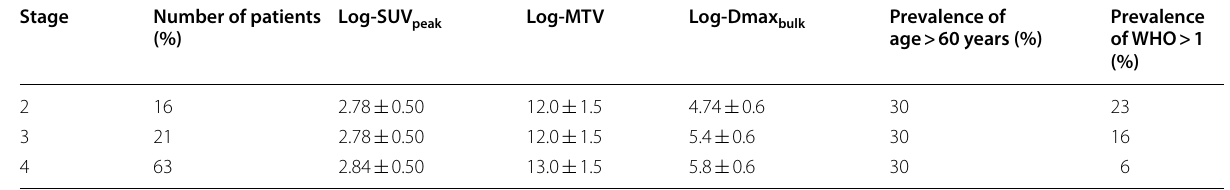
Table 1 PET and clinical characteristics used for simulations Stage Number of patients Log-SUV (%)